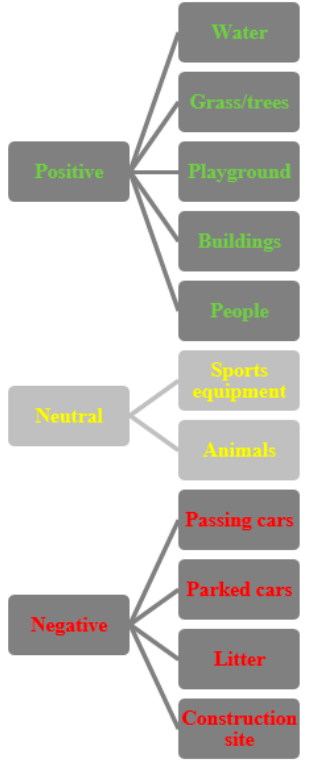
Figure 3. Visual elements and judgments.